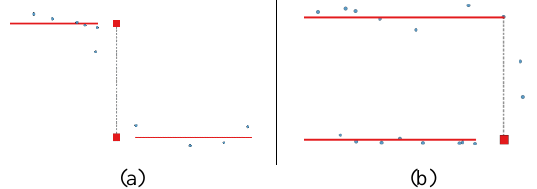
Figure 4. Special cases for adding corner points (red) for (a) Z-shape and (b) for U-Shape with missing line segment (dotted).